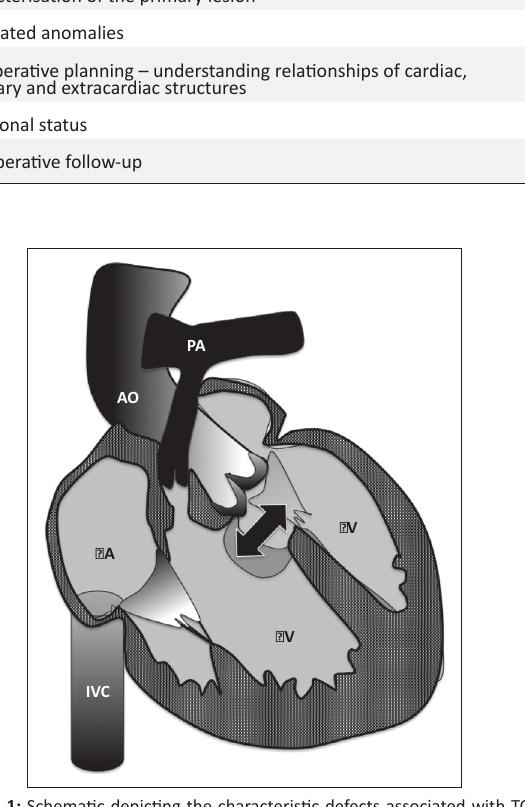
FIGURE 1: Schematic depicting the characteristic defects associated with TOF: RVOT obstruction and pulmonary atresia, right ventricular hypertrophy (RV), overriding aorta (Ao) and a large VSD (double-pointed arrow).